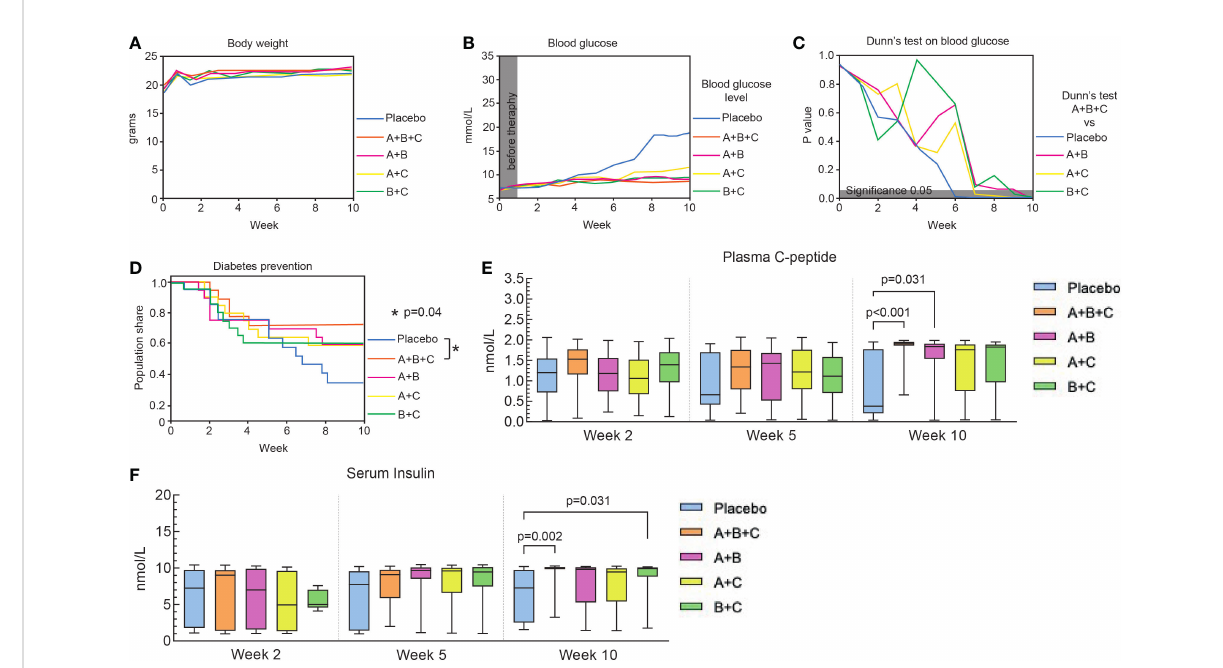
FIGURE 1 Triple therapy (A+B+C) prevents diabetes onset in NOD mice. This arm of the experiments was performed on 94 mice that had not developed diabetes at the start of drug therapy (blood glucose<13.9. mmol/L). The placebo, A+B+C, A+B and A+C groups included 19 mice each and the B+C group 18. (A) Changes in body weight of the mice in each group are shown as median values. The data were analyzed with the Kruskal- Wallis test with Dunn ’ s post hoc . No signi fi cant changes were found between the groups. (B) Changes in median blood glucose levels in each group over 10 weeks. (C) Blood glucose levels of the A+B+C group were compared with the other groups at different times using the Kruskal- Wallis test with Dunn ’ s post hoc . The gray area corresponds to a level of signi fi cance (p = 0.05). (D) Kaplan-Meier curves of the proportion of mice that were prevented from diabetes development. There was a signi fi cant difference between the A+B+C group and the placebo group (p = 0.04). No statistical differences were found when comparing the placebo group with the dual therapy groups (A+B [p=0.22], A+C [p=0.23], B+C [p=0.22]). (E) Plasma C-peptide levels were analyzed with the Kruskal-Wallis test with Dunn ’ s post hoc . Signi fi cant differences were found by comparing the placebo group with A+B+C (p<0.001) and with A+B (p= 0.031) groups at week 10. (F) Serum insulin levels were analyzed with the Kruskal-Wallis test with Dunn ’ s post hoc . Signi fi cant differences were found by comparing the placebo group with the A+B+C (p=0.002) and with the B+C (p=0.031) groups at week 10. Plasma C-peptide and serum insulin levels are shown as box-whisker plots representing median values with interquartile width and